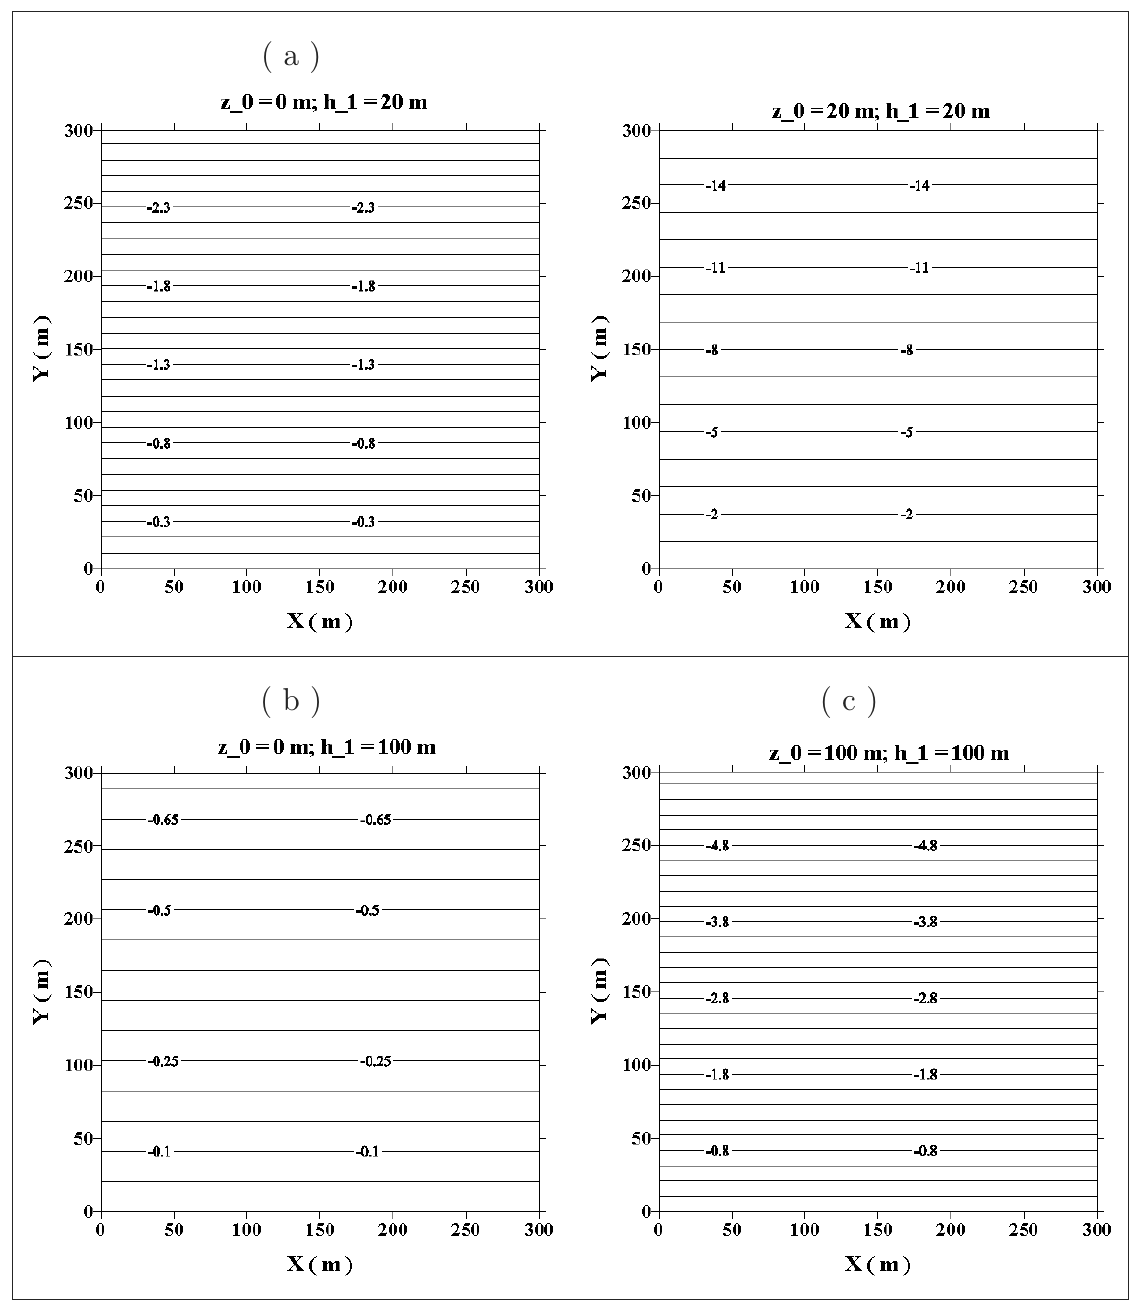
Fig. 10 – Contour maps of the difference of the vertical component of the magnetic field in nanotesla between one substratum with σ 2 = 0 . 03 S/m and another with σ 2 = 0 . 003 S/m. h 1 represents the thickness of the sea